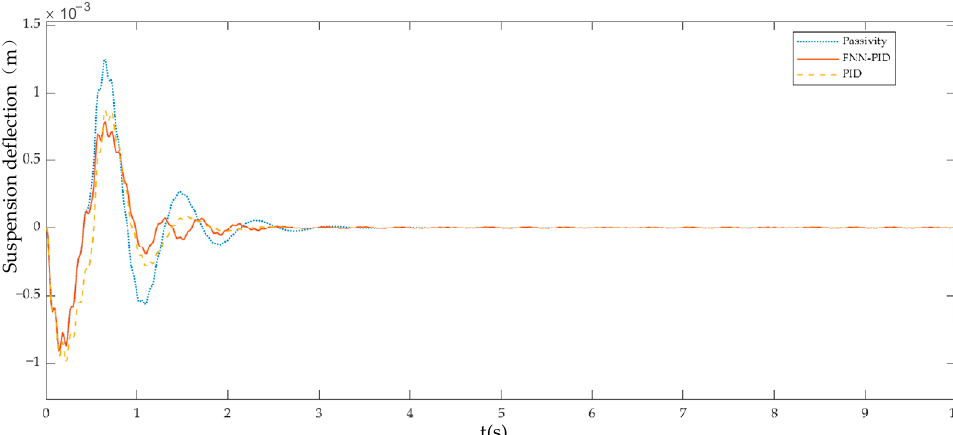
Figure 5. Step response diagram of Sprung Mass Acceleration.